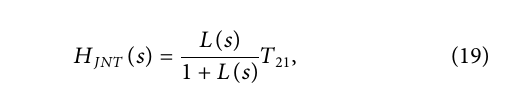
Frontiers in Robotics and AI |